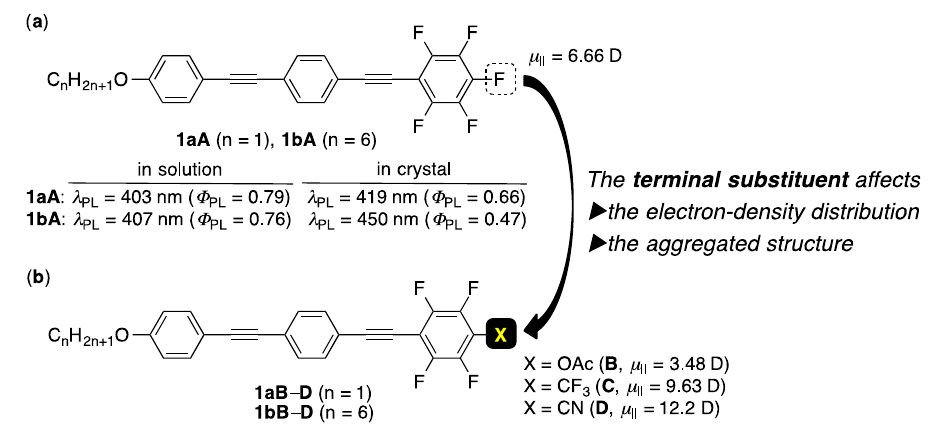
Figure 1. Molecular structures used in ( a ) a previous study and ( b ) the present work. µ || : Calculated dipole moment along the long molecular axis.